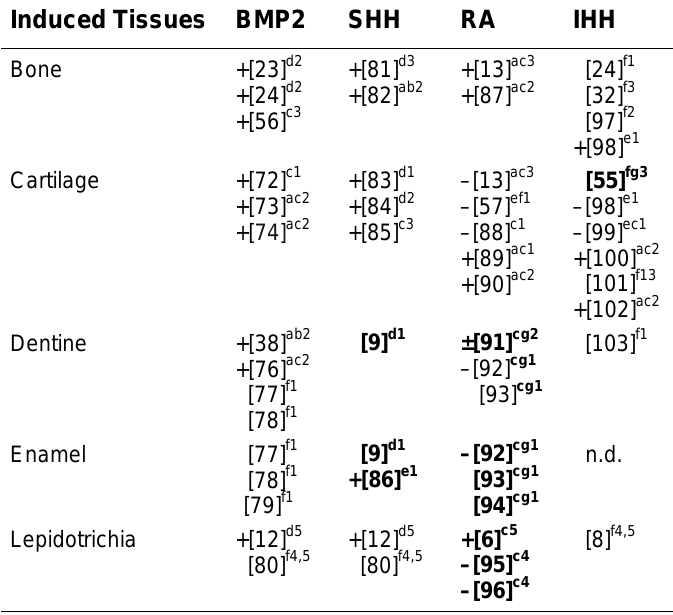
Signals Inducing Skeletal Tissues and Ray Dermal Bone Differentiation in